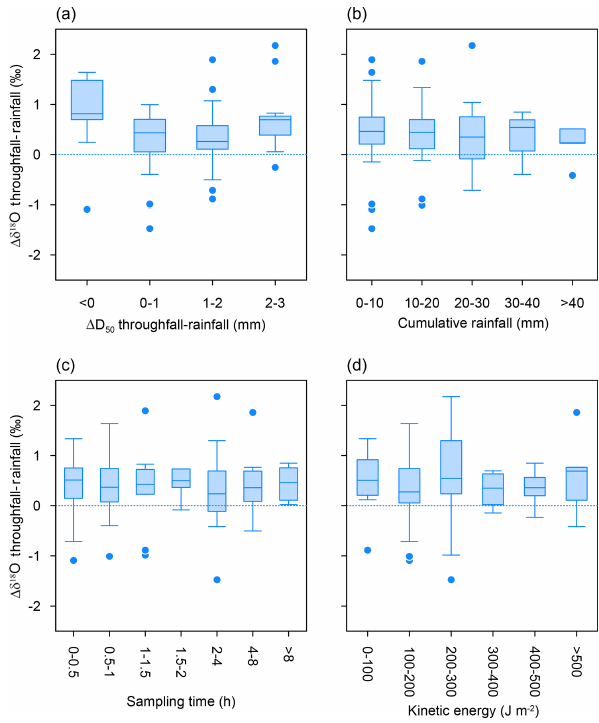
Figure 6. Boxplot of the isotopic shift ( δ 18 O TF–RF ) versus classes of (a) differences in median volume drop diameter ( D 50_TF–RF ), (b) cumulative rainfall throughout the rainfall event, (c) sampling time (i.e. time each 5mm sample took to be filled) and (d) rainfall kinetic energy per sample. The light blue dots represent